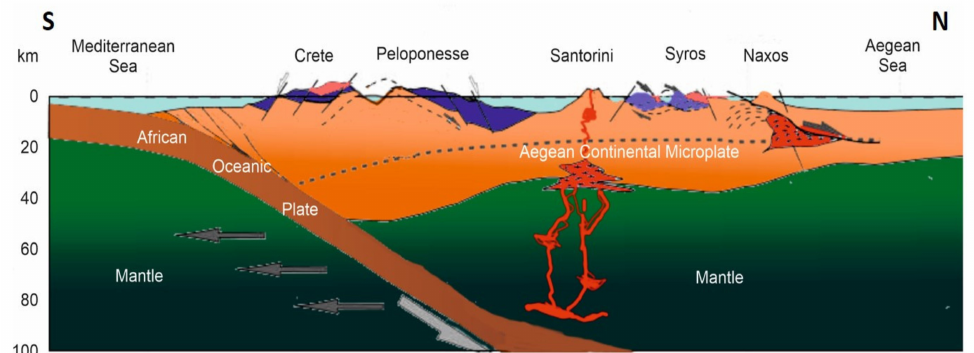
Figure 6. Schematic reconstruction of the northward dipping Hellenic Subduction